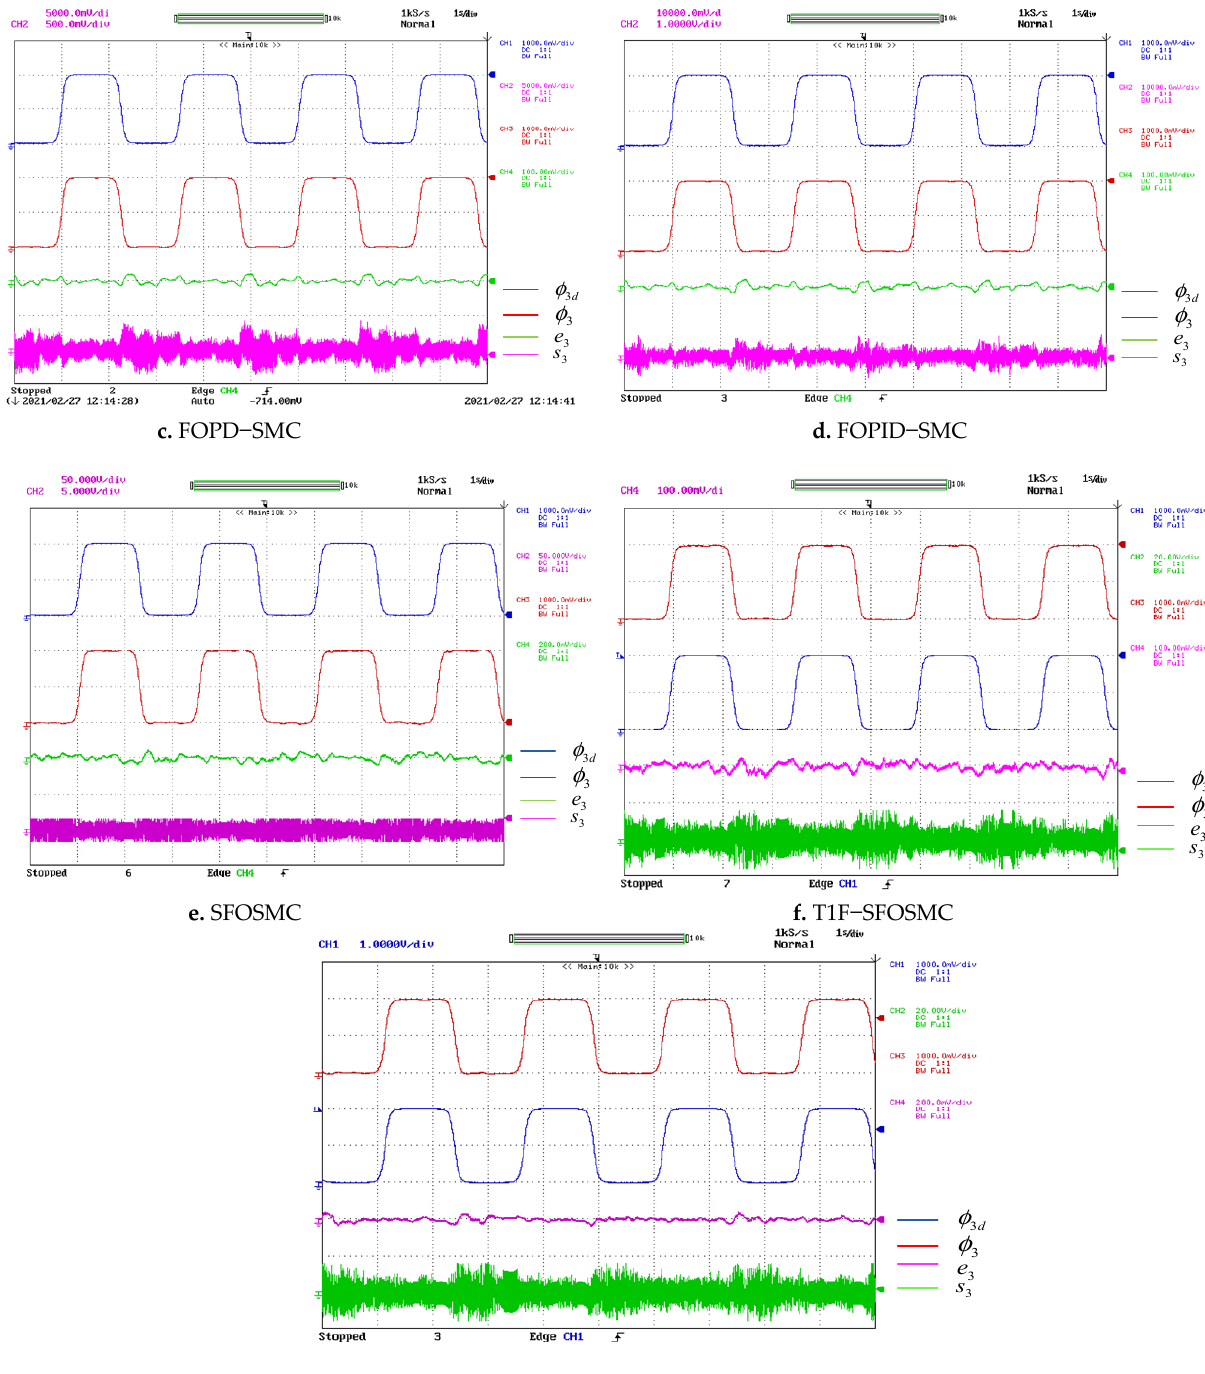
Figure 15. Trajectory tracking of the 3DOF surgical manipulator for Joint3.